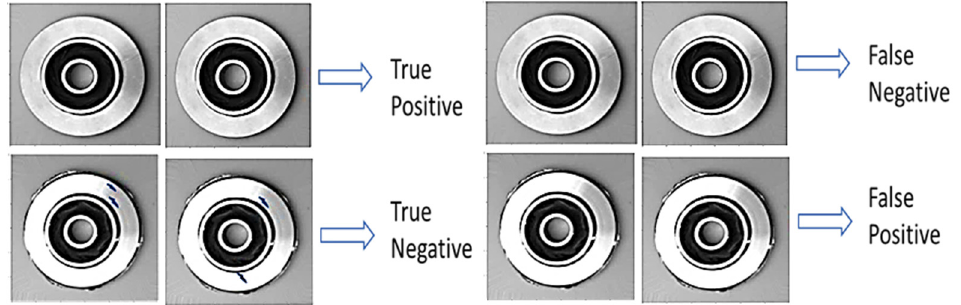
Figure 9. True positive, false negative, true negative, and false positive samples of the impeller casting products.